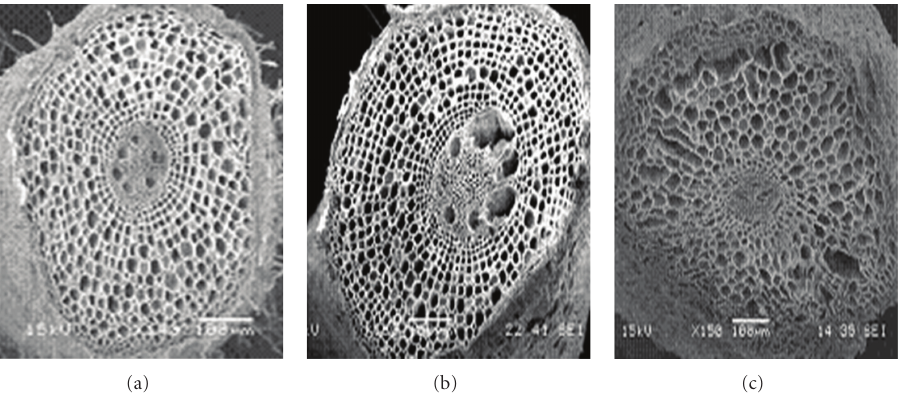
Figure 3: Scanning electron microscopy photographs showing root cortical tissue of Paspalum vaginatum under (a) 0, (b) 24, and (c) 48dSm − 1 .